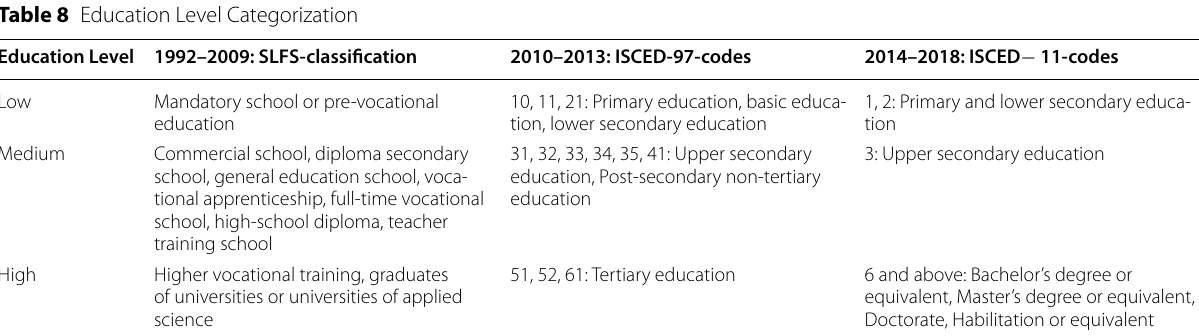
I used the most recent ISCED-codes where available. For 1992–2009 data the SLFS’s own education classification was used, in 2010 the ISCED-07 classification was introduced, in 2014 the ISCED-11 classification. “No education” was not recorded before 2014 and I therefore refrain from assigning it to any of the education